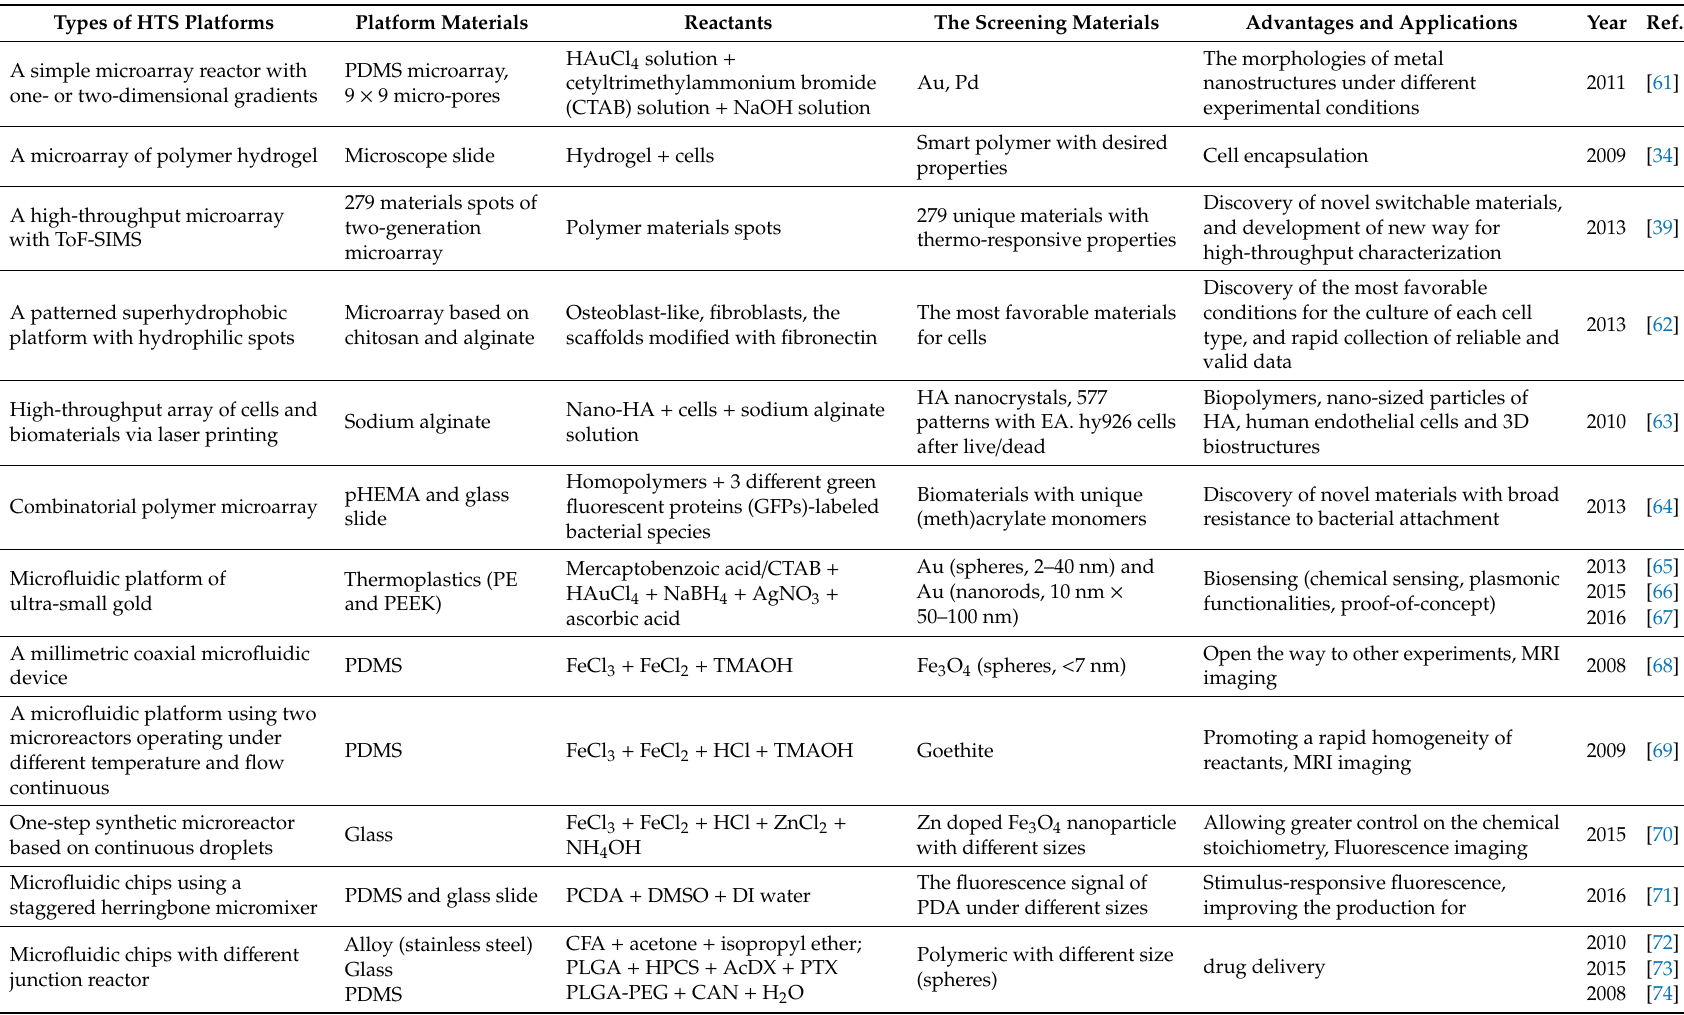
Table 1. Examples of high-throughput platforms and their advantages in materials